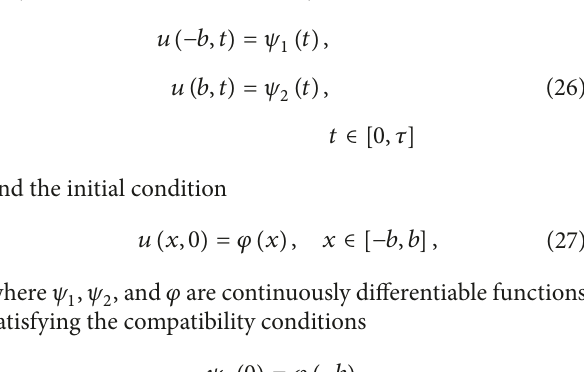
Figure 1: The absolute value of the difference |𝑢(𝑥,𝑡) − 𝑢 26 (𝑥, 𝑡)| between the exact and the approximate solutions for problem